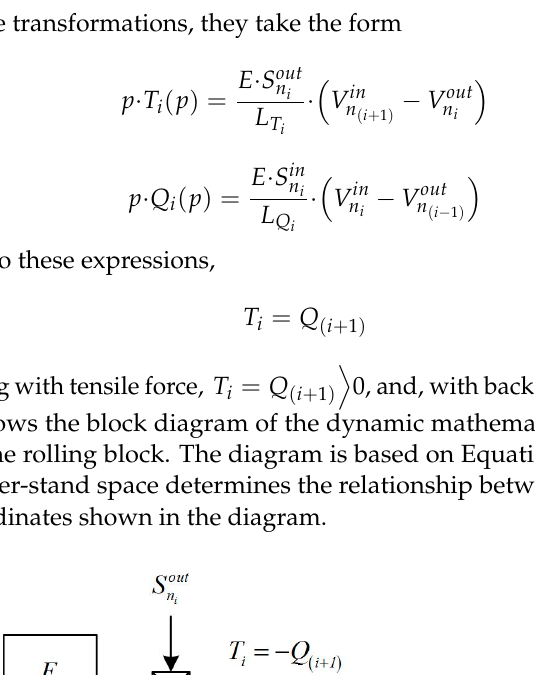
Figure 8. Inter-stand space, design diagram.